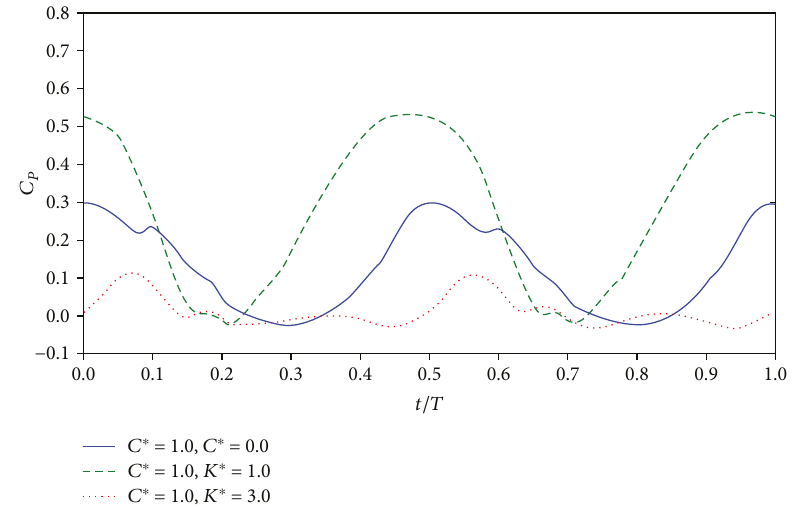
Figure 6: The time variation of power coe ffi cient of the considered cases with C ∗ = 1 0 and K ∗ = 0 0 , 1.0, and 3.0.